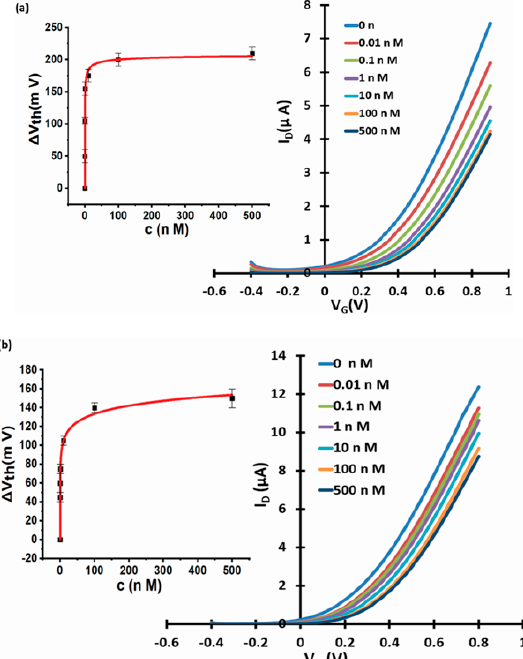
Figure 10. WGTFT fluoride sensors with lightly loaded resin under fluoride and carbonate. Response of lightly La-loaded resin to ( a ) fluoride and ( b ) carbonate. Insets: response characteristics with fits to Equation (3).